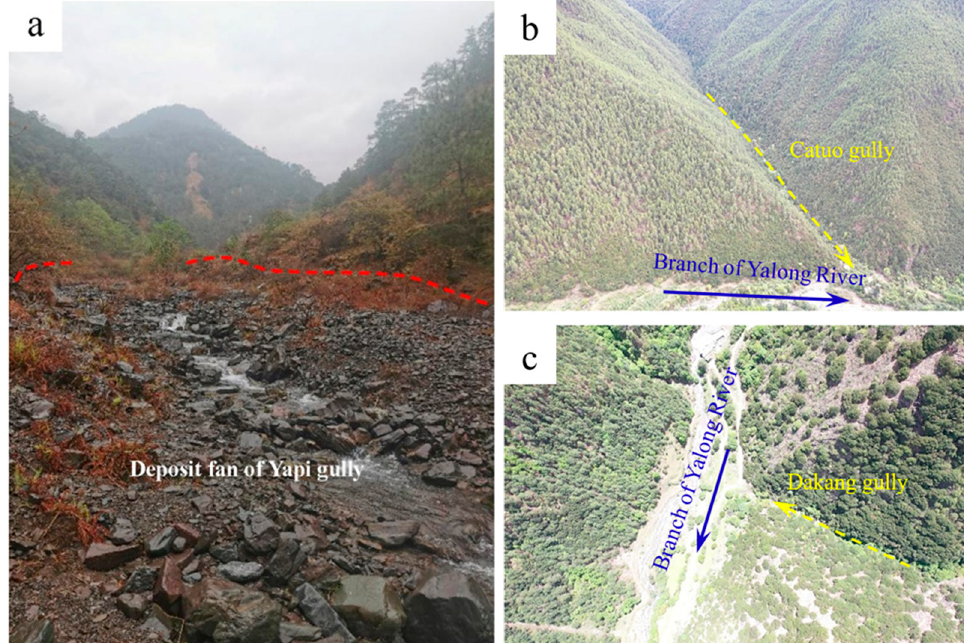
Figure 4. Typical deposit fan in the study area. ( a ) Field investigation of the Yapi gully deposit fan, ( b ) UAV photography of the outlet of the Catuo gully, ( c ) UAV photography of the outlet of the Dakang gully.